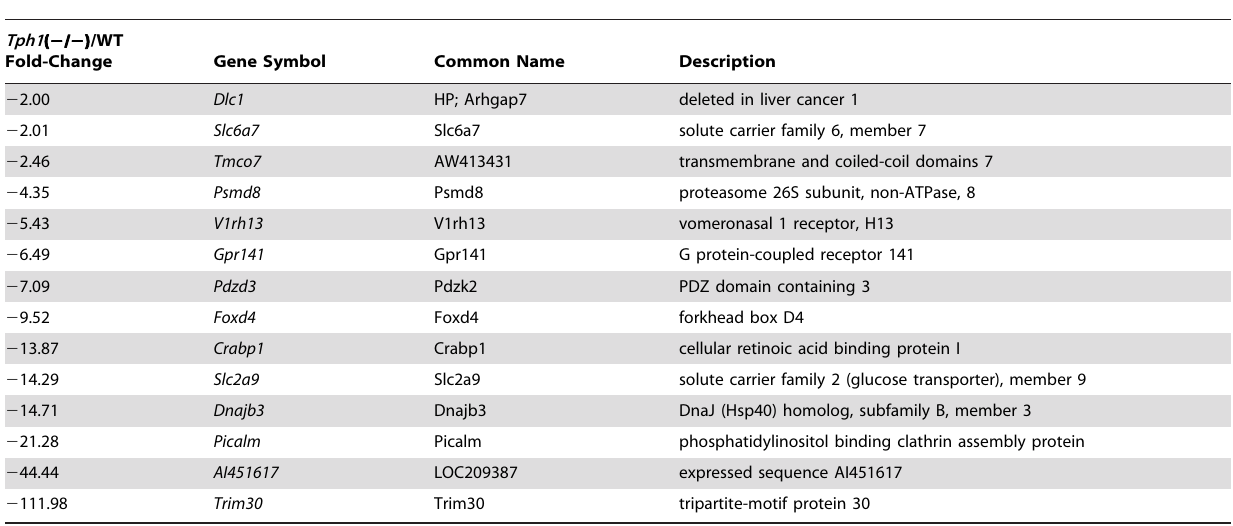
These data were generated from lung tissue harvested from WT and Tph1 ( 2 / 2 ) female mice (n=6 per group). The above changes were statistically significant (p , 0.025). doi:10.1371/journal.pone.0017735.t004 PLoS ONE |